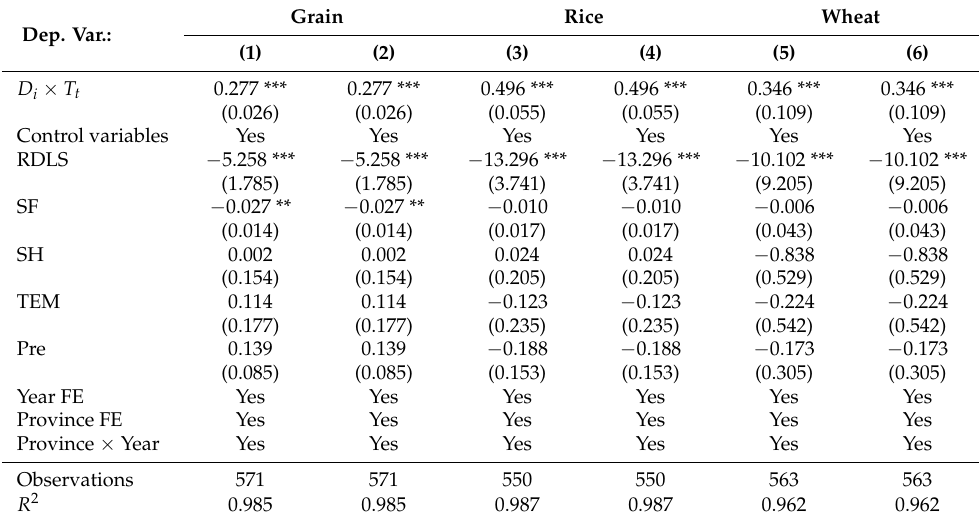
Table 9. Controls for other